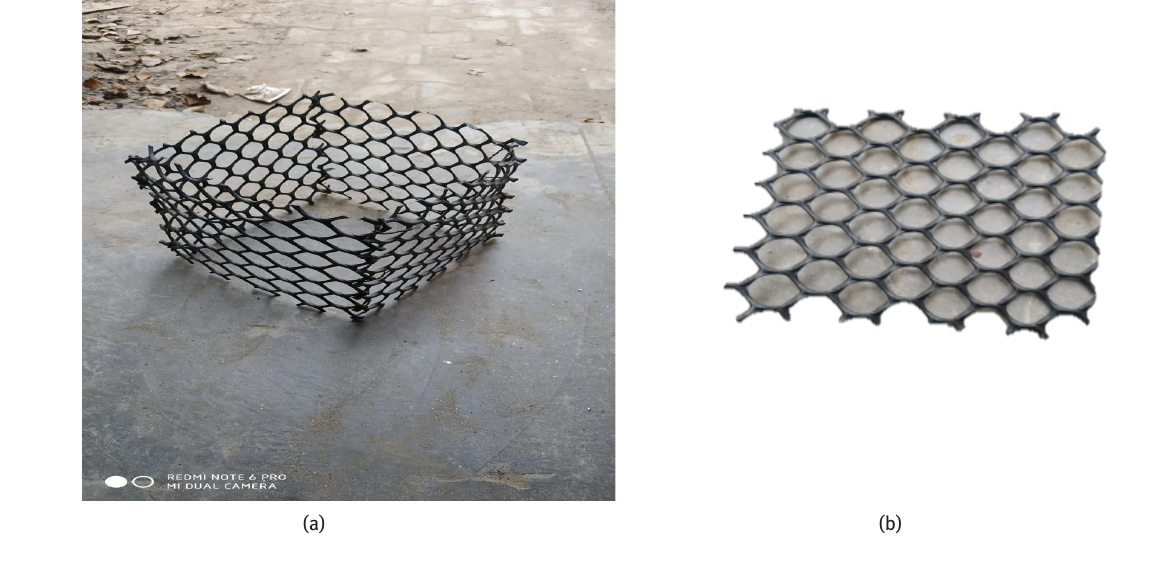
Figure 3: Geogrid used in the experimental study as (a) confiner (b)